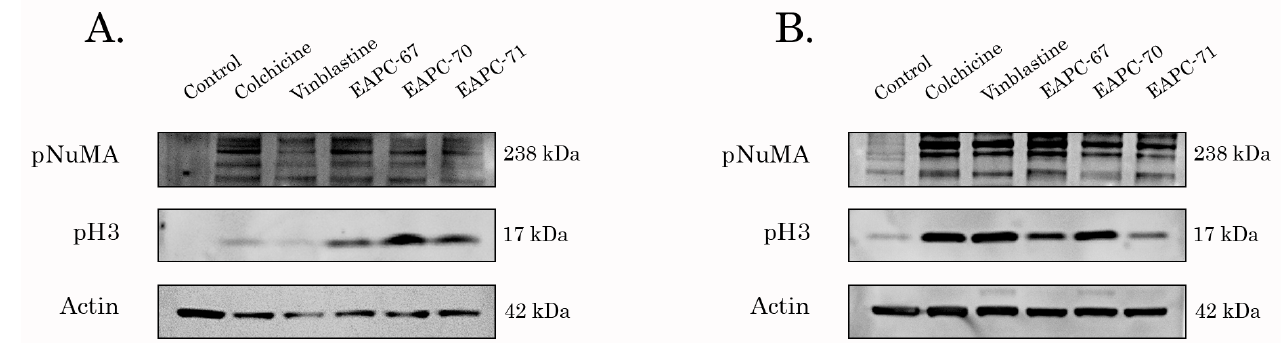
Figure 2. Immunoblot analysis for the expression of M-phase specific proteins (e.g., phospho-NuMA Ser395 and phospho-H3 Ser10) in H1299 lung cancer ( A ) and HCC1806 breast cancer ( B ) treated with DMSO (negative control), EAPC-67, EAPC-70, EAPC-71 (both 10 µ M), Colchicine (0.05 µ M) and Vinblastine (0.01 µ M) for 24 h. Actin stain was used as a loading control.